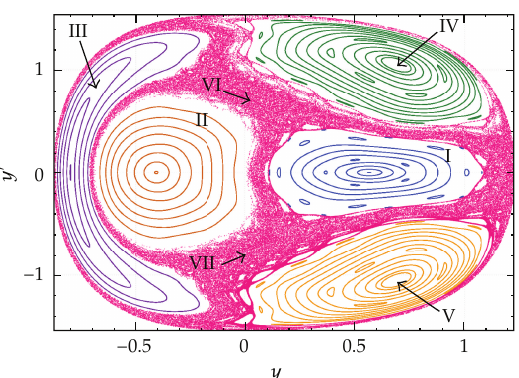
Figure 7: The Poincare section at E (cid:7) 0 . 4 (cid:5) in sixth-order Hamiltonian (cid:6) . We distinguish five families of closed invariants: I (cid:5) blue (cid:6) , II (cid:5) brown (cid:6) , III (cid:5) purple (cid:6) , IV (cid:5) green (cid:6) , and V (cid:5) orange (cid:6) . The unstable invariant points are marked as VI and VII, while the big pink area is a single chaotic orbit.